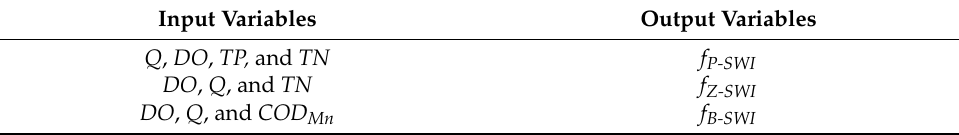
Table 1. The input and output variables of the